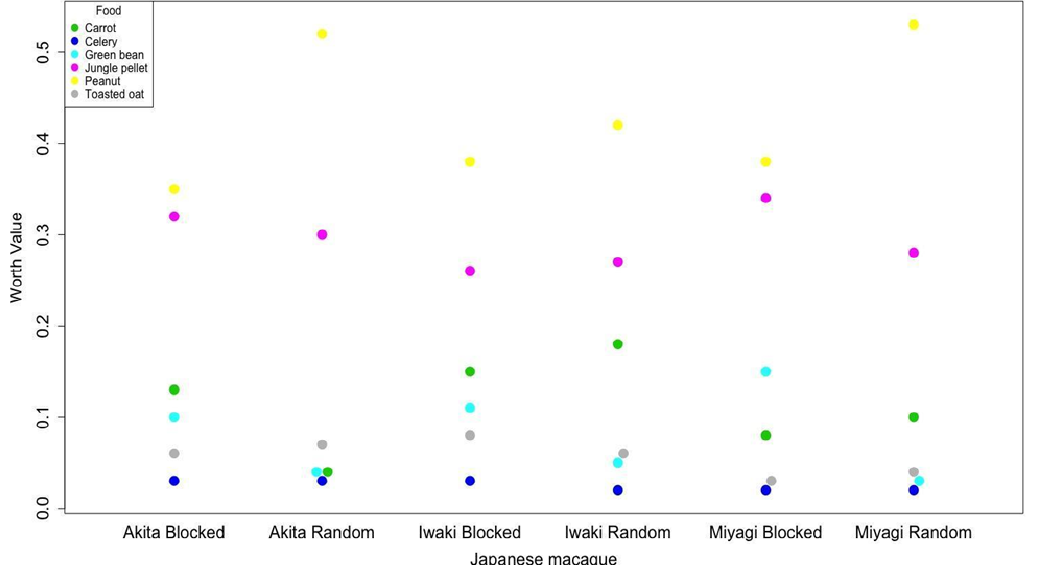
Note. Changes in preference (indicated by worth value) are shown for each food between blocked (Huskisson et al., 2020) and random (Phase 1 here) presentation